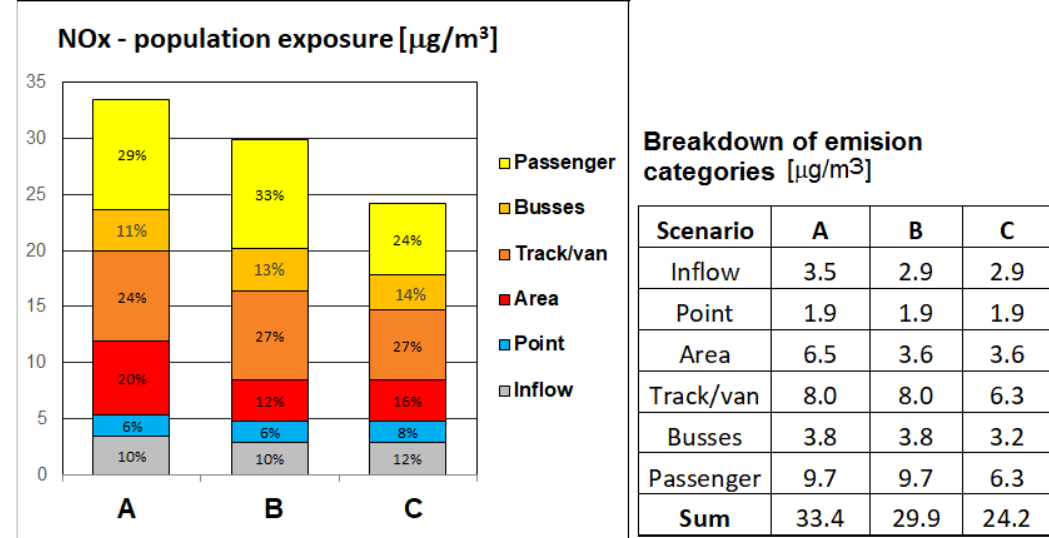
Figure 3. Modifications of NOx exposure.